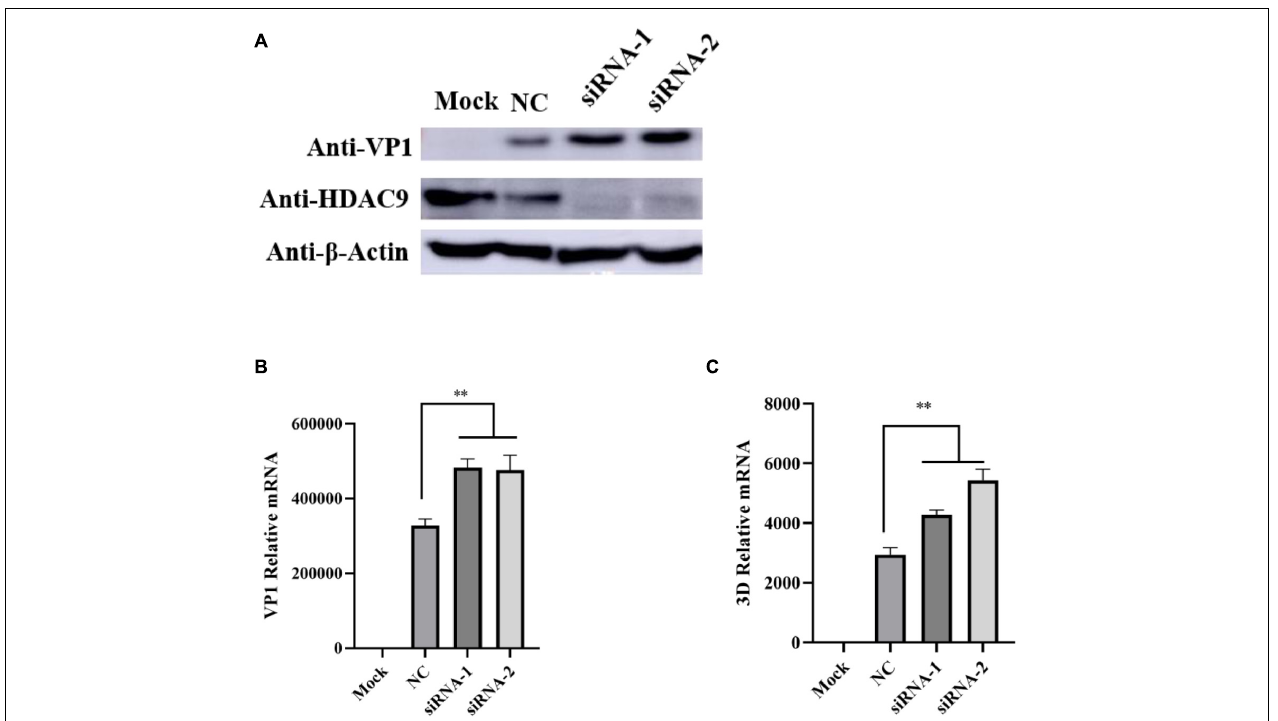
FIGURE 5 | Knockdown of HDAC9 enhances FMDV replication in PK-15 cells. PK-15 cells were transfected with control siRNA (NC) or siRNA targeting to HDAC9 for 24 h, and then infected with FMDV (MOI = 1) for 6 h. (A) Western blot analysis was performed to detect the expression of HDAC9 and viral proteins VP1 with indicated antibodies. (B,C) Total RNA was extracted and qRT-PCR was performed to detect the expression of FMDV VP1 and 3D relative mRNA. All experiments were repeated three times, with similar results. Data are presented as mean ± SD ( n = 3). Statistical significance was analyzed by Student’s t -test: * p < 0.05, ** p <